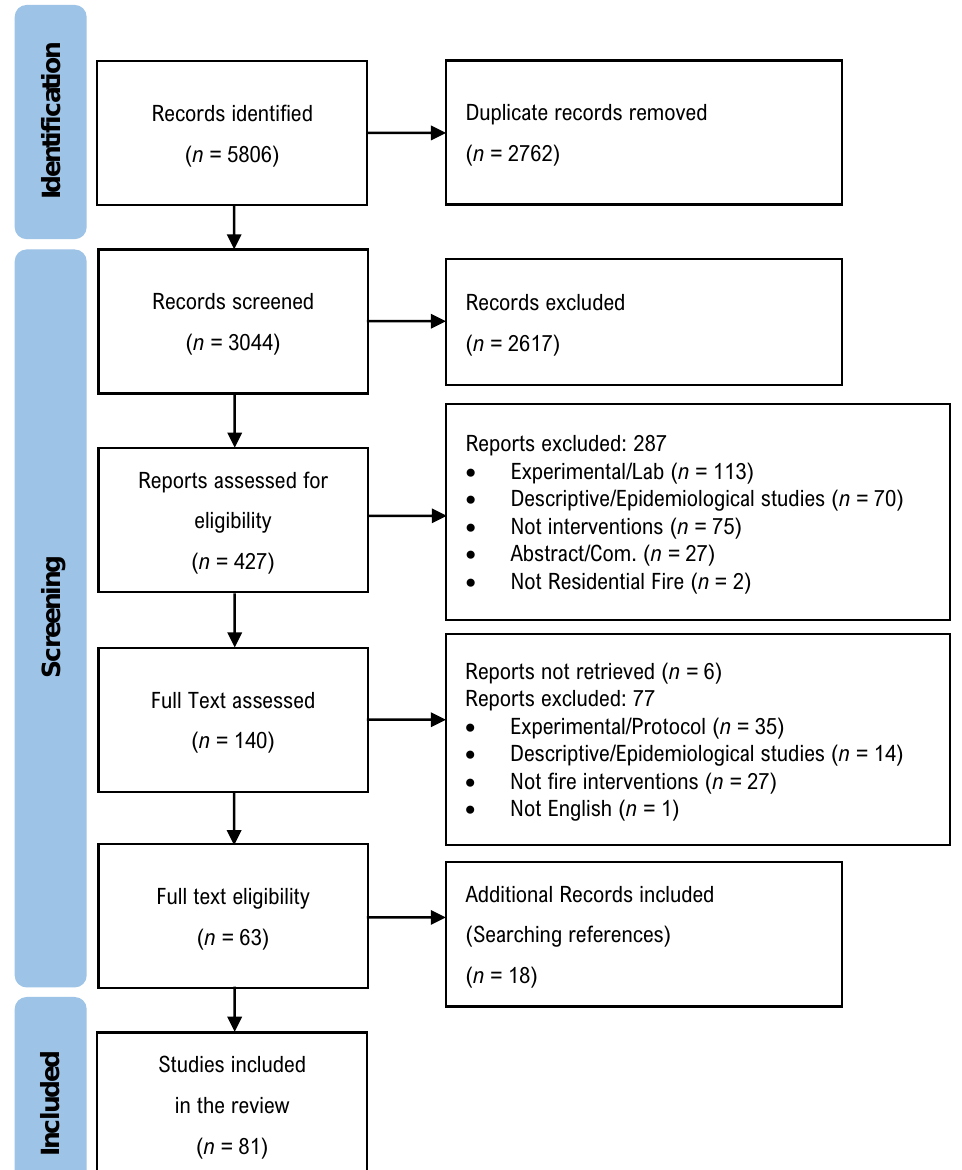
Figure 1. Preferred Reporting Items for Systematic Reviews and Meta-Analyses (PRISMA) flow diagram.